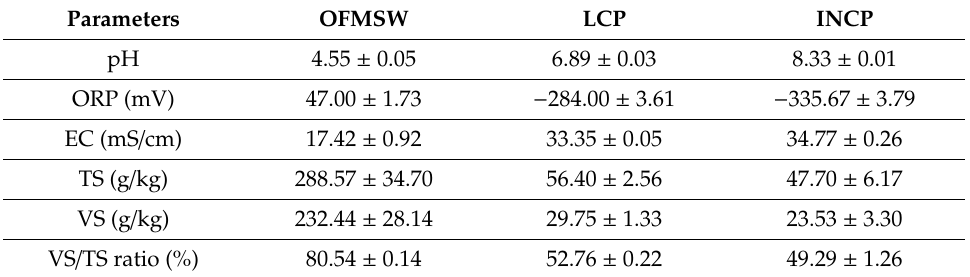
Table 1. Chemical characteristics of the substrate, leachate, and